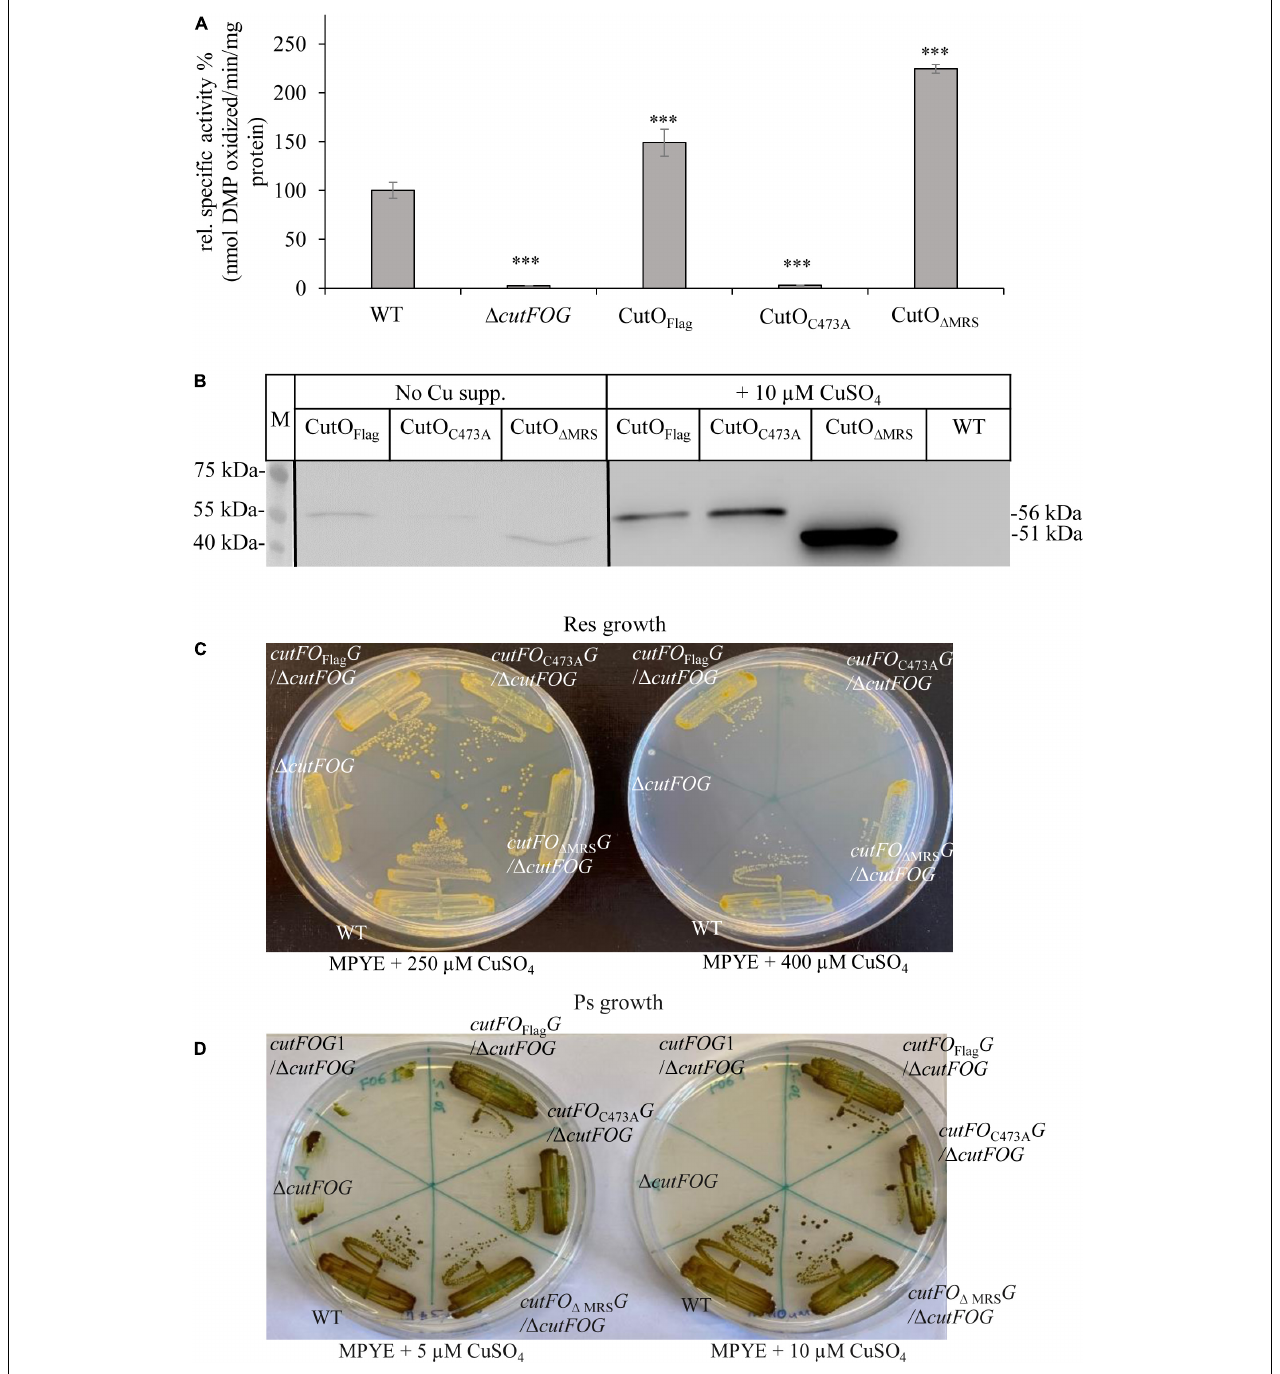
FIGURE 10 | Activity, steady-state levels, and Cu sensitivity of different CutO mutants. (A) CutO activity of the CutO mutant variants CutO C473A , carrying a mutation in the T1Cu binding motif, and CutO (cid:49) MRS , in which the methionine-rich segment (MRS) was deleted, was determined by using 50 µ g protein of the periplasmic fraction isolated from strains grown on MPYE medium in the presence of 10 µ M CuSO 4 . Three independent experiments were performed with three technical repetitions and the error bars reflect the standard deviation ( n = 9). The activity of the WT strain was set to 100% and the relative activities of the other strains were calculated. Statistical analyses were performed as in Figure 1 , using the activity of the WT strain as reference. ( ∗ ) refers to p - values ≤ 0.05; ( ∗∗ ) to p -values ≤ 0.01, and ( ∗∗∗ ) to p -values ≤ 0.001. (B) Immunoblot analysis of Flag-tagged wild type CutO and its mutant variants grown in the presence and absence of CuSO 4 supplement. After isolation of the periplasmic fraction, 50 µ g protein were separated on 12% SDS PAGE and treated with anti-Flag antibodies. (C) Respiratory (Res) and (D) photosynthetic (PS) growth of R. capsulatus strains carrying a plasmid born copy of CutO Flag or its mutant variants (CutO C473A and CutO (cid:49) MRS ) on MPYE medium supplemented with different amounts of CuSO 4 . The cutFOG 1/ (cid:49) cutFOG strain carrying the cutF C − Strep O Flag G MycHis construct was used as an additional control for Ps growth.